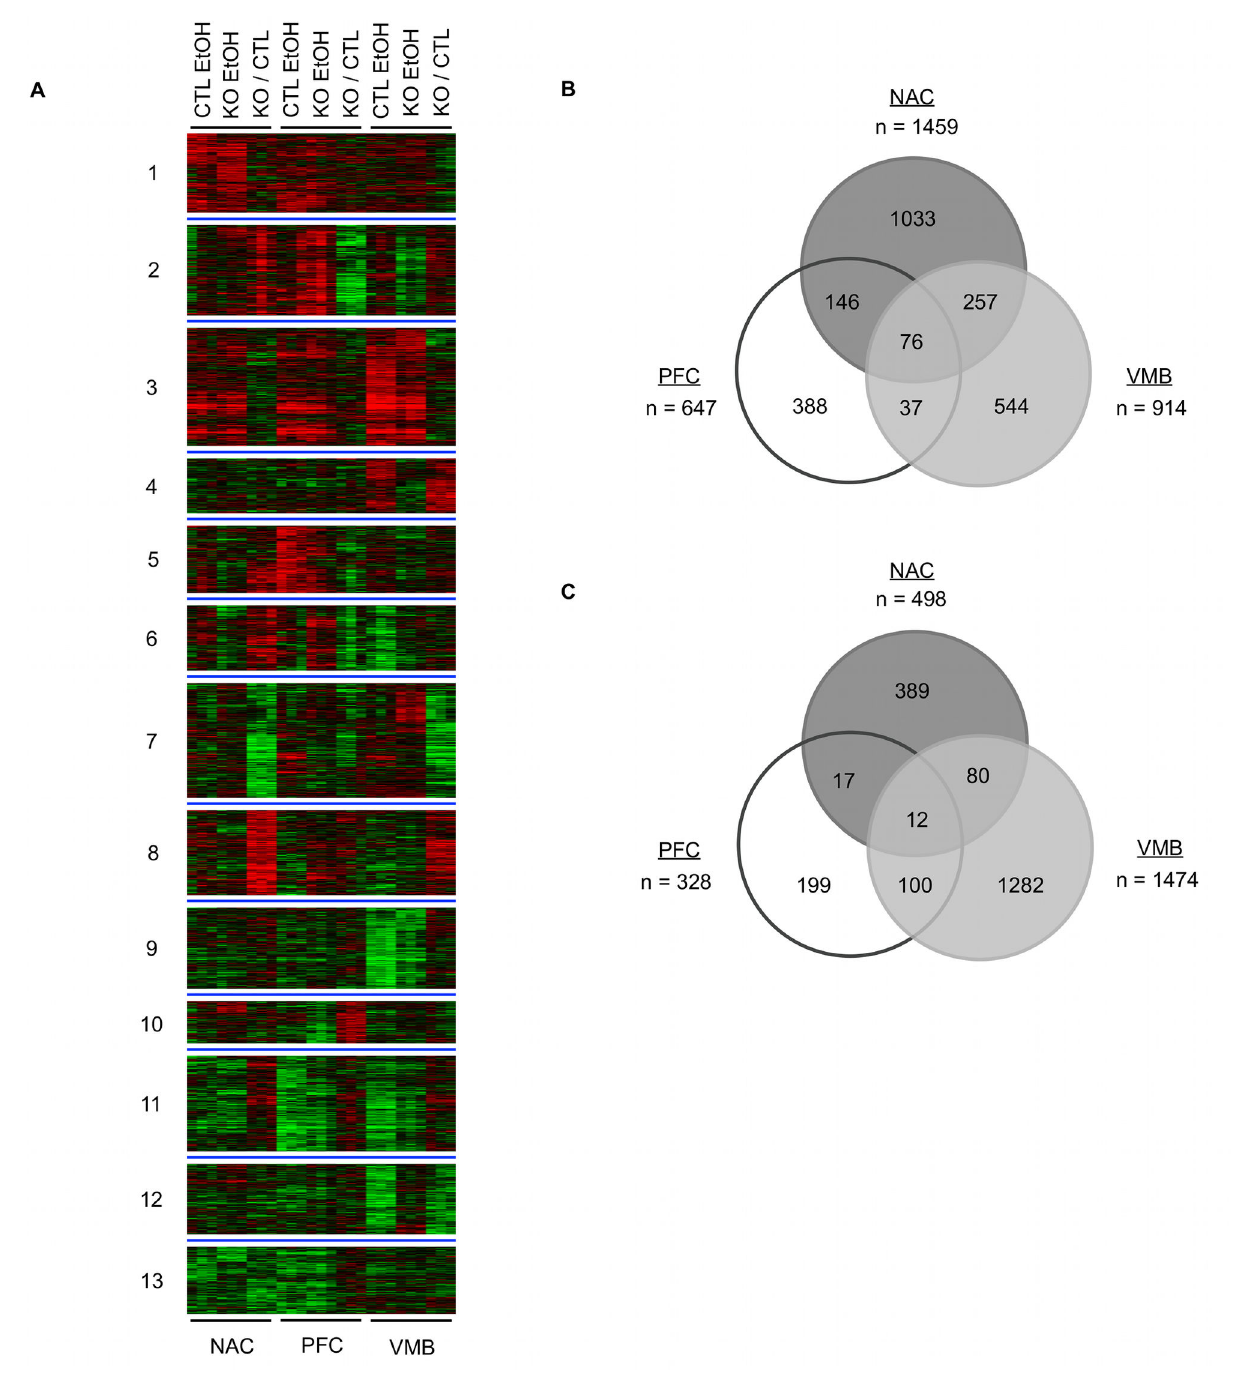
Figure 1. Basal and ethanol-responsive gene expression differences between Fyn knockout mice and controls. (A) k- Means cluster analysis of differential gene expression for S-scores; green = decreased relative expression, red = increased relative expression, black = no change in expression (Control EtOH = CTL EtOH, KO EtOH = Fyn Knockout EtOH, KO / CTL = Fyn Knockout Saline / Control Saline). (B) Venn diagram of overlapping and non-overlapping genes differentially expressed between saline treated Fyn knockout mice and controls. (C) Venn diagram of overlapping and non-overlapping genes differentially expressed between acute ethanol (3 g/kg) treated Fyn knockout mice and controls. (NAC - Nucleus Accumbens, PFC - prefrontal cortex, and VMB - ventral midbrain).